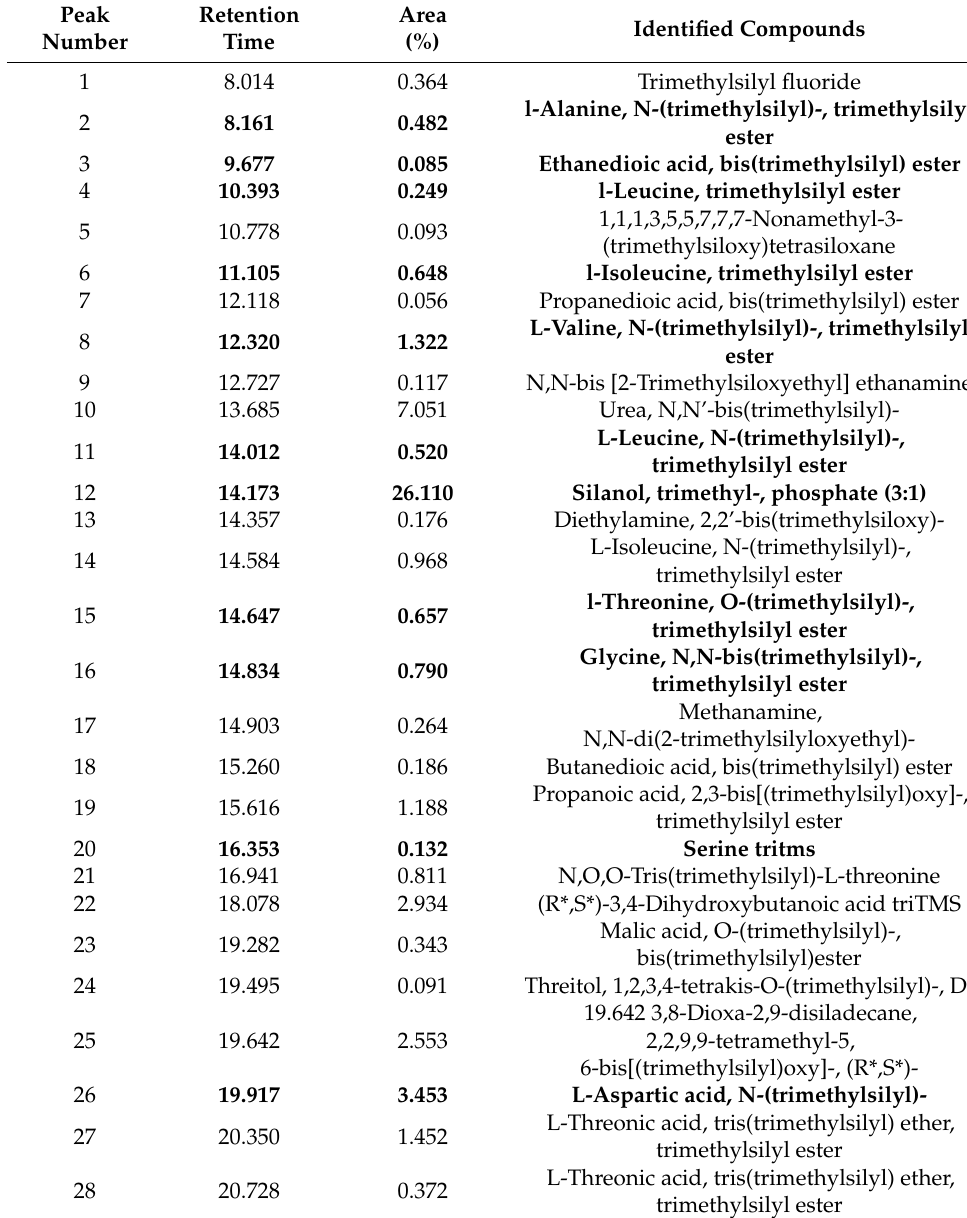
Table 1. Chemical compounds identified in HLRE via GC-MS